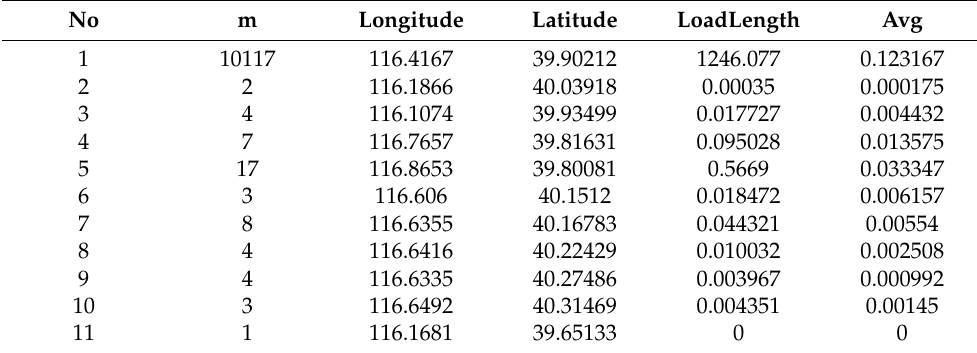
Table 18. The clustering results of HF_DBSCAN for the DS4 dataset.